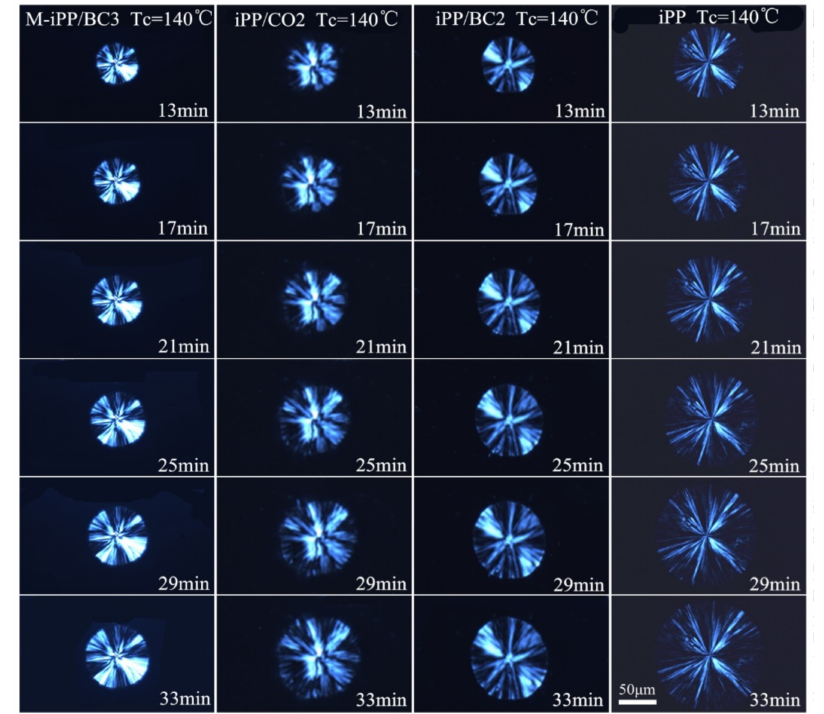
Figure 7. The POM images of the iPP/BC composites at 140 ◦